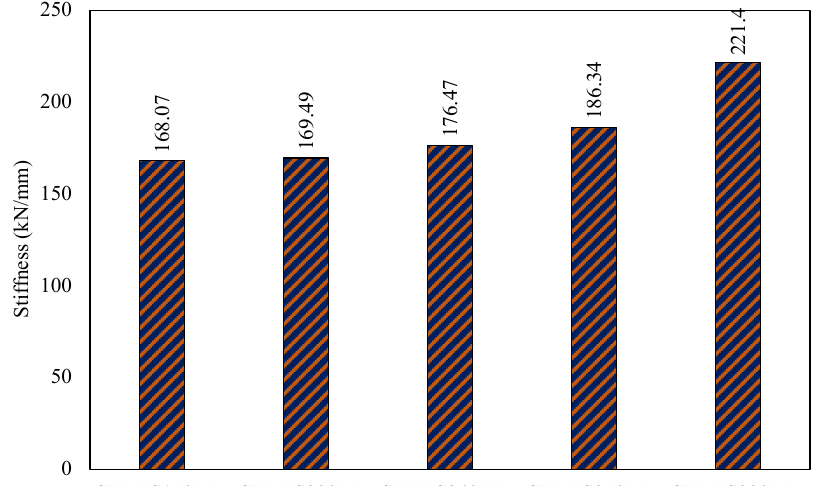
Figure 20. Stiffness of group 3.